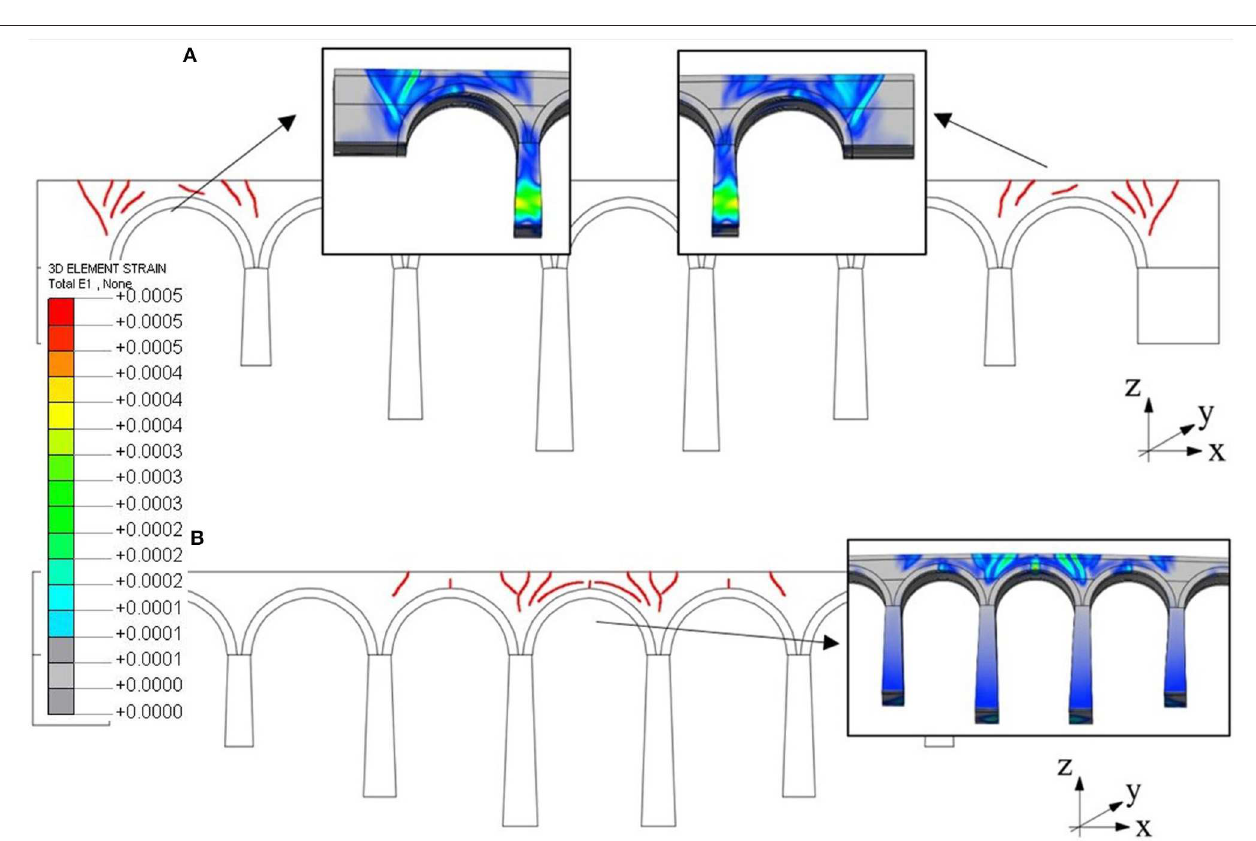
FIGURE 10 | Damage state of the spandrel walls. (A) Strain state in the longitudinal direction (X). (B) Strain state in the transversal direction (Y).